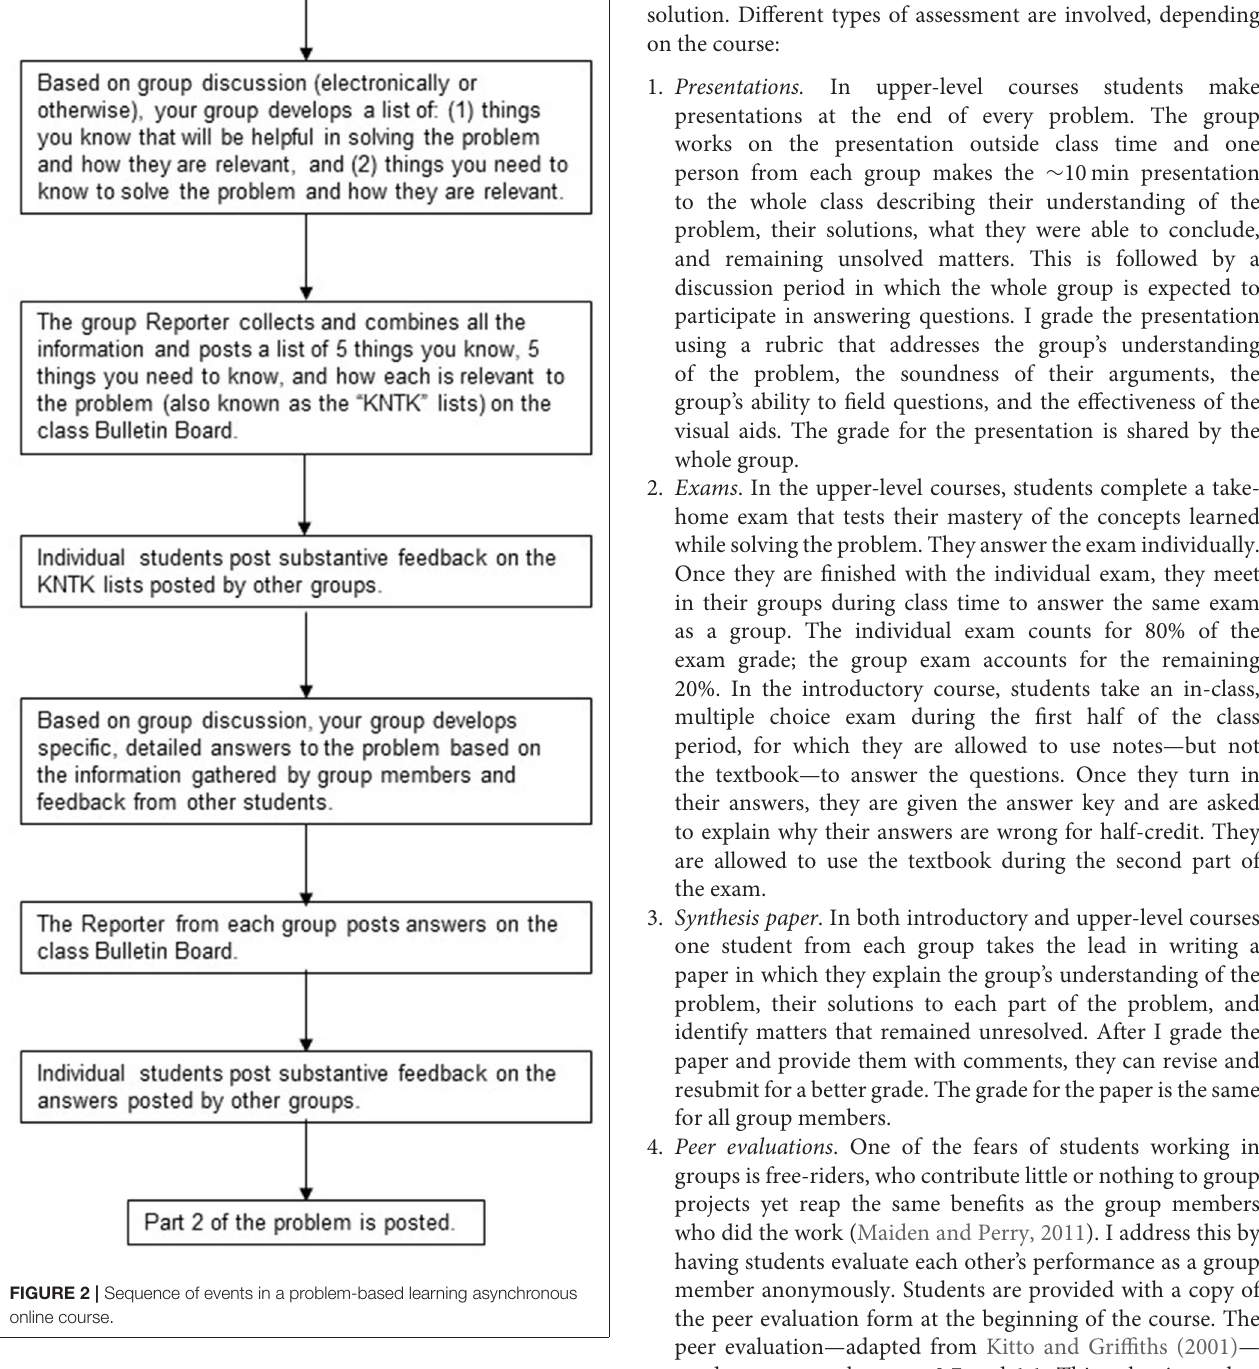
in the story moves along to keep the students’ attention, (iii) the Goldilocks rule applies: the problem is challenging enough that the students believe they can solve it, but is not so easy that it is readily solvable, and (iv) humor makes the problem more approachable—after all, how difficult can something be if it’s